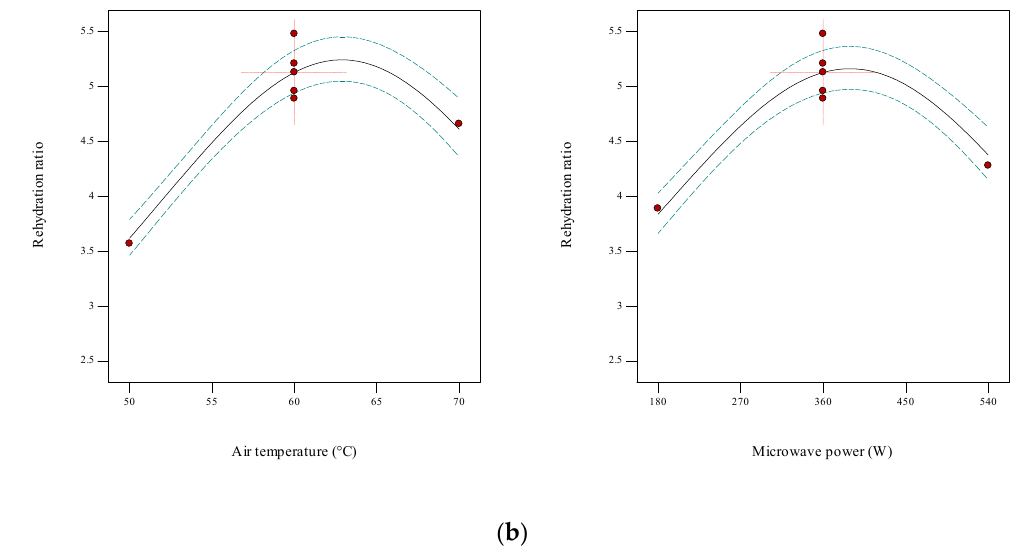
Figure 6. ( a ) The combined effect of air temperature and microwave power on rehydration ratio ( b ) The effect of air temperature and microwave power alone on rehydration ratio.